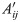
This figure shows a network of e-MID precipitants for April 2000.Thicknesses of edges Aij′ are recalculated from the real weights Aij′=log(Aij/(0.25·Amin)). The core-periphery structure and weight heterogeneity are easily observed. Size and color of the nodes correspond to out strength of the node computed with rescaled weights. Palette is color coded so that the blue links (nodes) have the lowest weight (out strength) while red carry the largest weight (out strength).